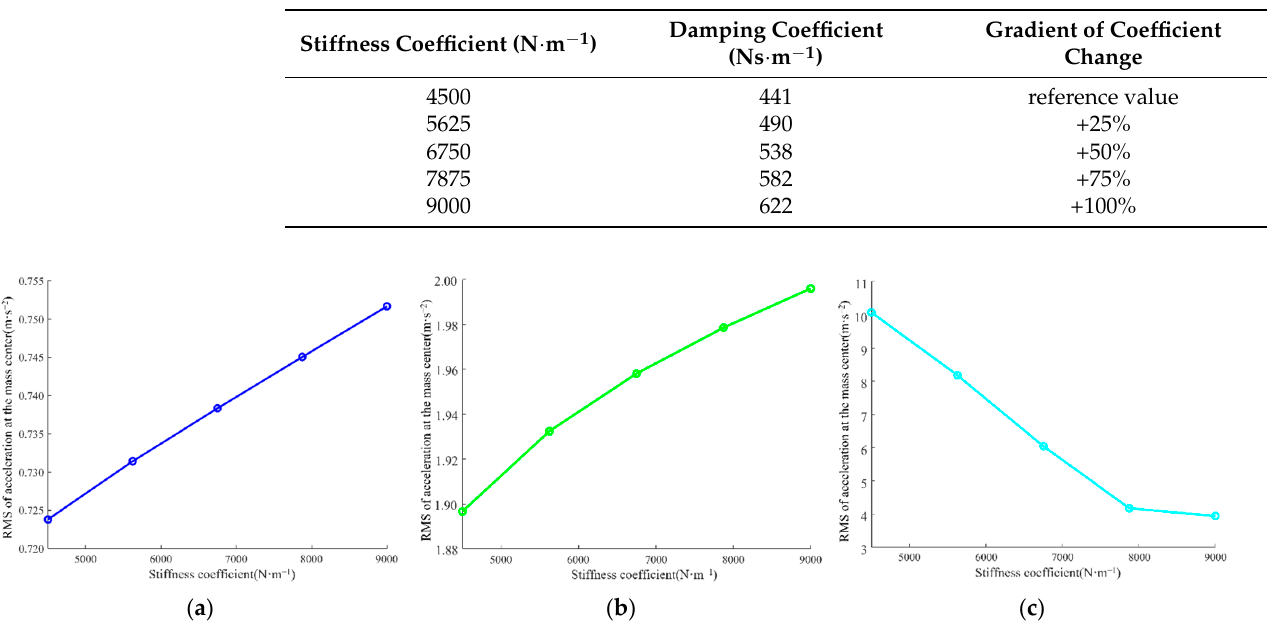
Table 4. Simulation parameters of stiffness value with bow waves.